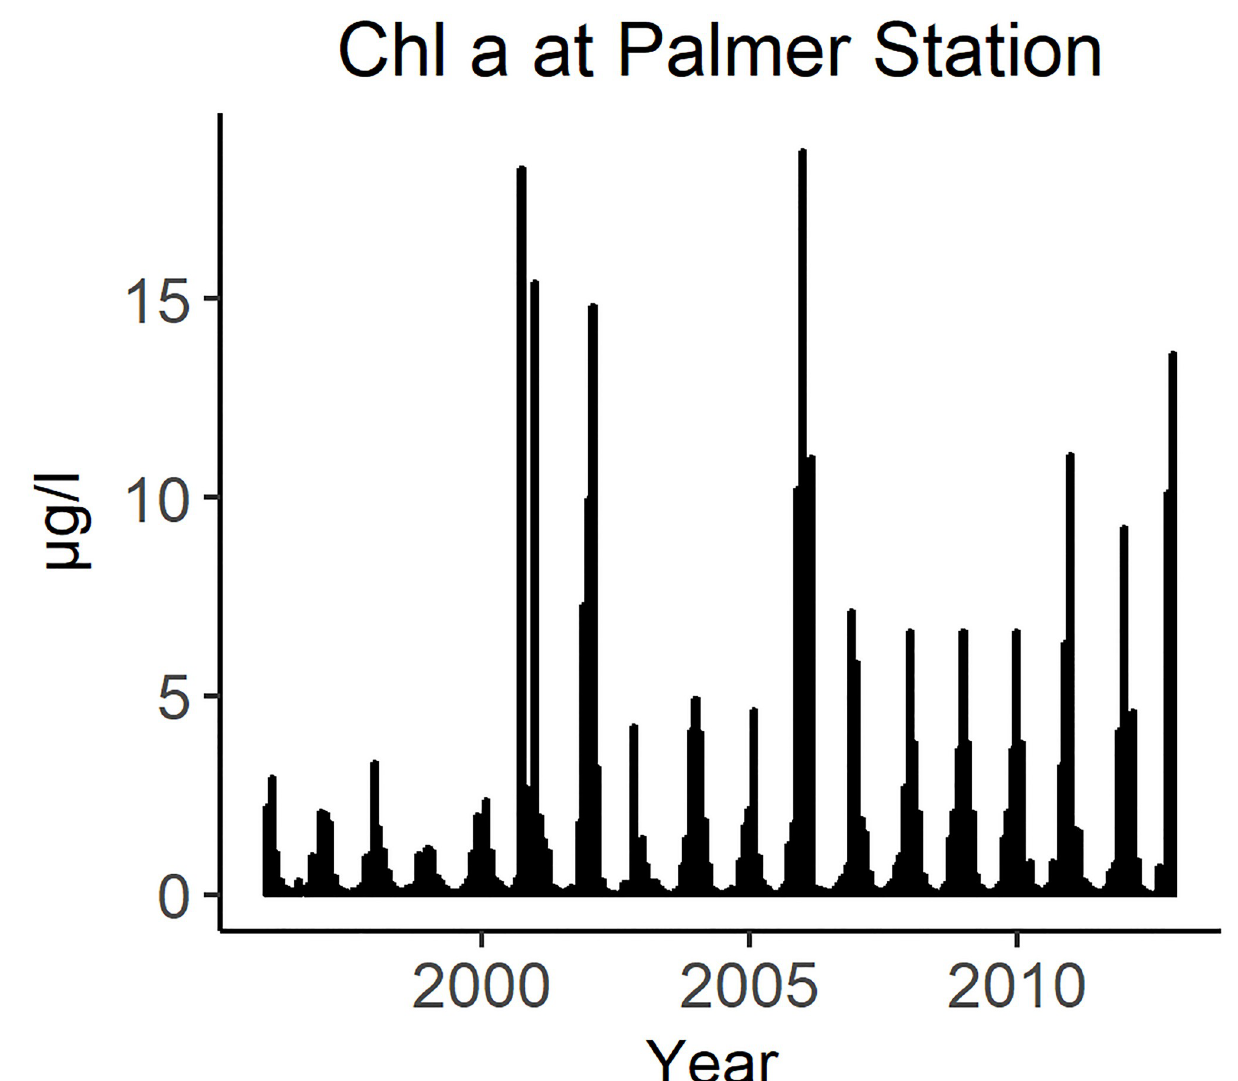
Fig 5. Monthly chlorophyll a concentration documented by the Palmer